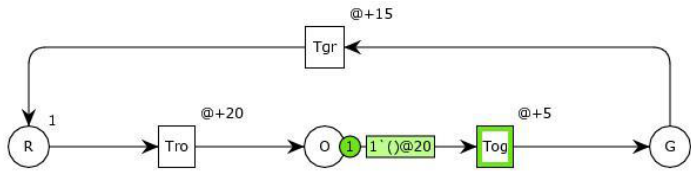
Figure 3. CPN Model of Traffic Light after Firing of Transition Tro.